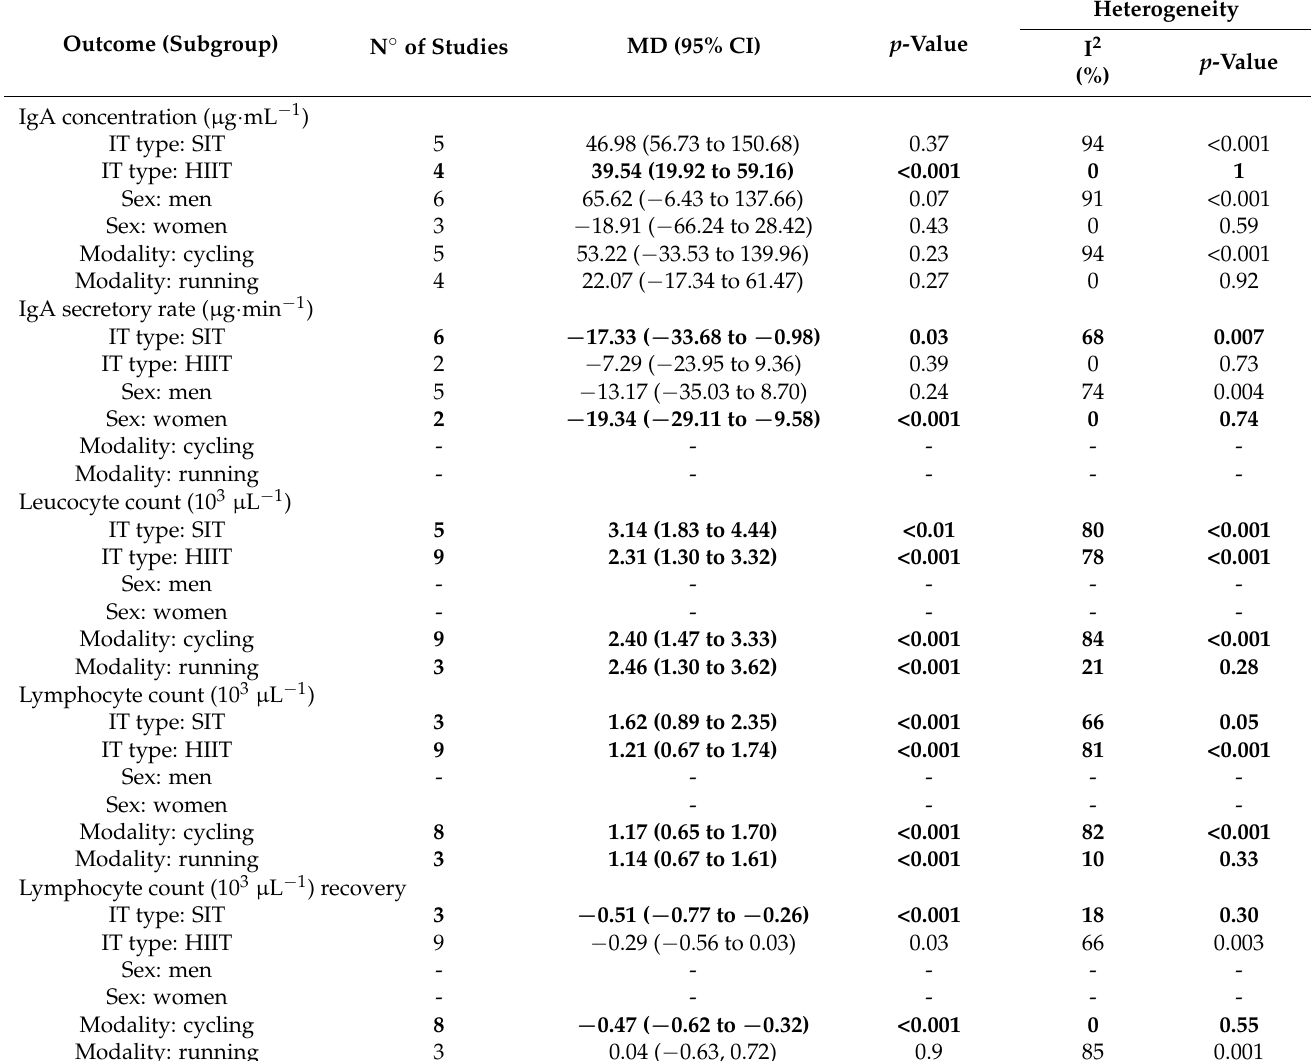
Table 4. Subgroup analysis of overall effects of interval training on immune